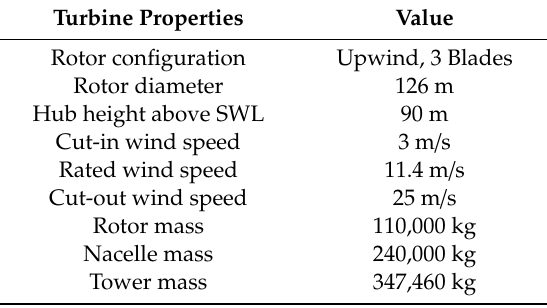
Table 1. Selected properties of the NREL 5MW baseline wind turbine.